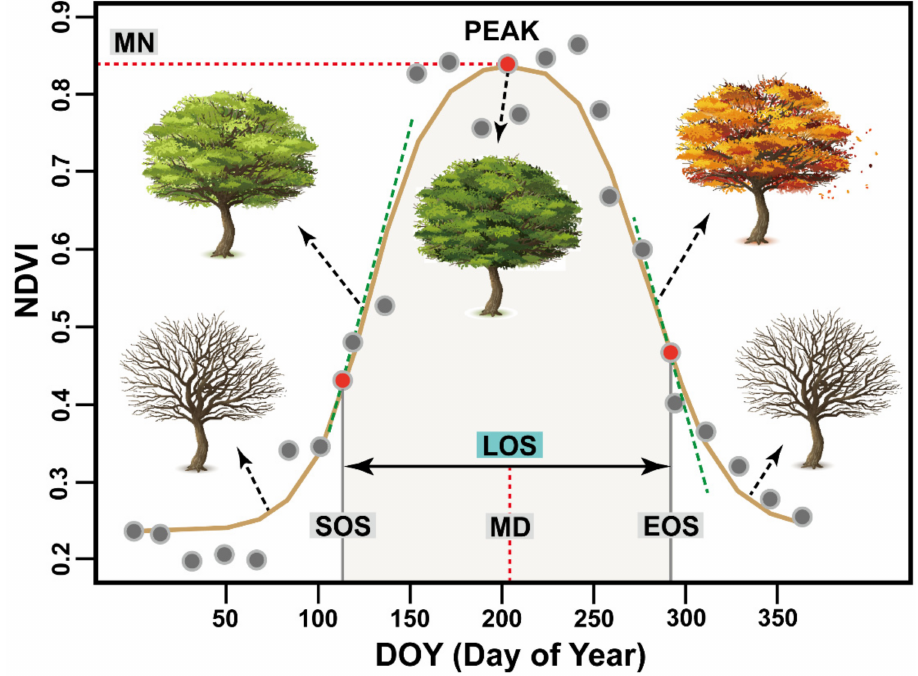
Figure 2. The description of phenology metrics correlations extracted using the NDVI time se- ries